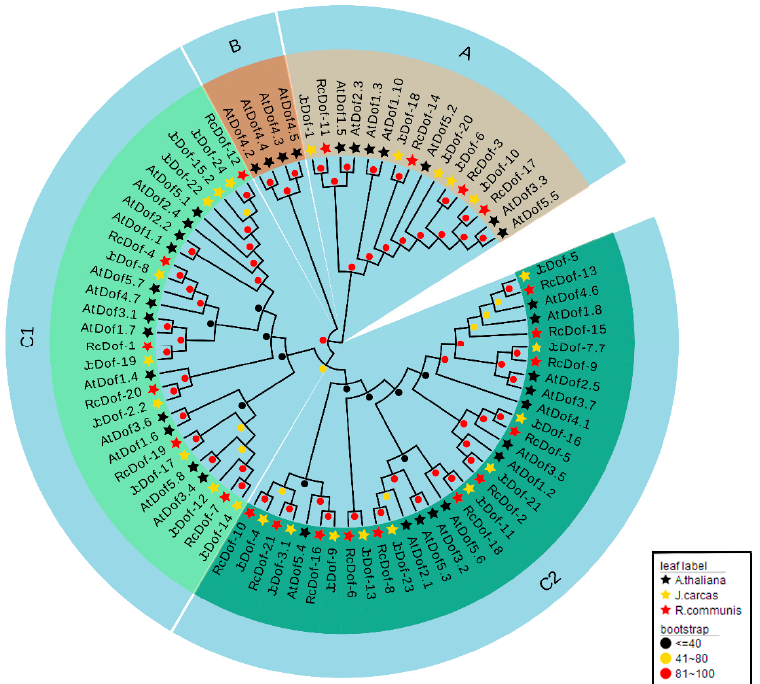
Figure2. Phylogenetic relationships among J. curcas , A. thaliana , and R. communis Dof proteins. The neighbor-joining tree was created using the MEGA6.0 program (bootstrap value set at 1000). Thirty-six (36) AtDof proteins marked with black pentacle, 24 JcDof proteins marked with yellow pentacle, and 21RcDof proteins marked with red pentacle. The resulting phylogenetic tree was clustered into three major groups (A, B, and C), which were supported by a bootstrap value over 80%. The Dof proteins in Group C were further divided into two sub-groups, C1 and C2, supported by a bootstrap value over 40%. The detailed information of all the Dof proteins is listed in Supplementary TableS2.